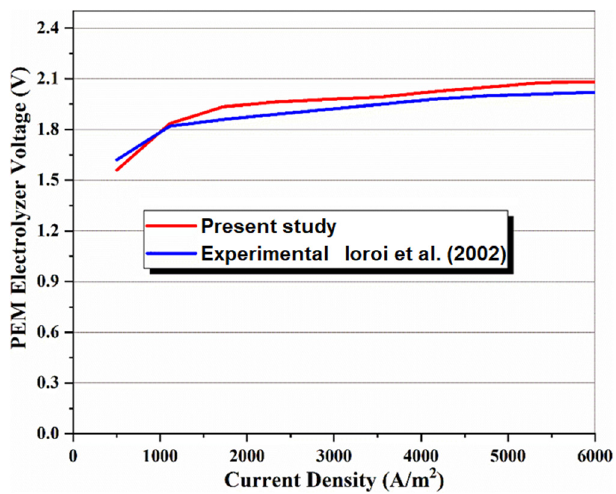
Figure 3. Comparison of effect of mass flow rate on thermal efficiency with published experimental work [50,51]. Table 6. Comparison of present study results with work of Eldessouky and Ettouney [34], to vali- date the MSF desalination subsystem.